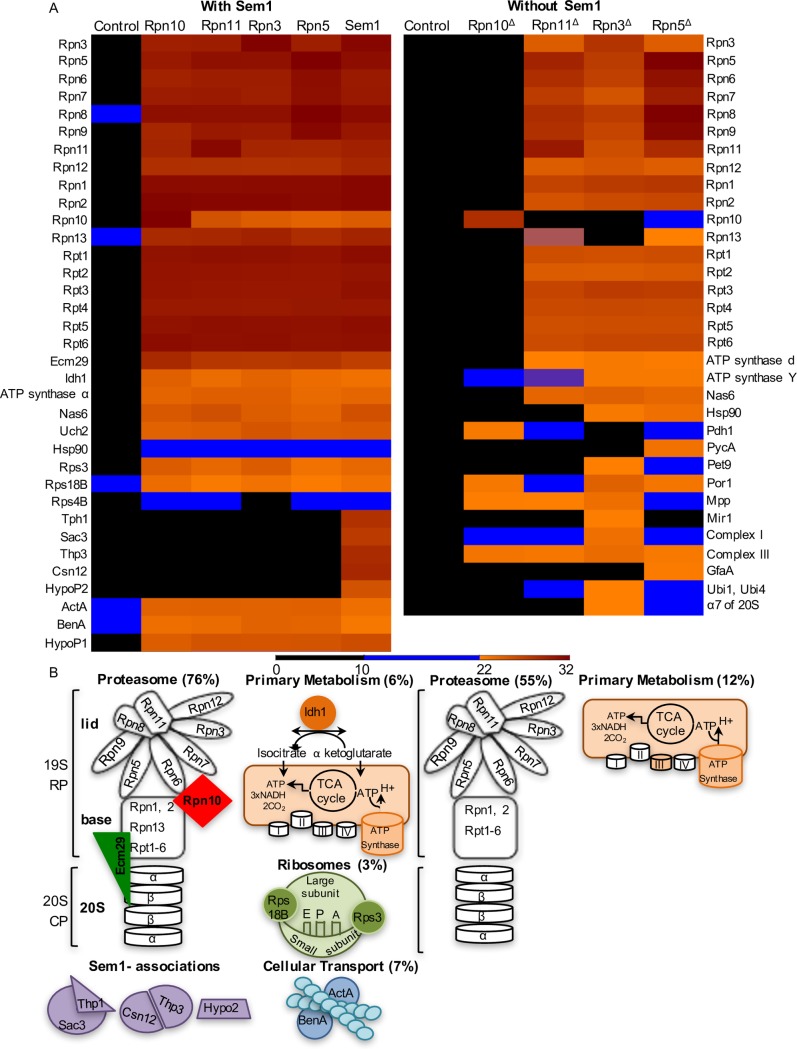
Proteins co-identified with Sem1 and 19S RP in the presence or absence of Sem1.(A) 34 proteins associated with 19S RP proteins fused to GFP in strains carrying Sem1. Proteins were identified in three biological replicates plotted as heat map representing LFQ intensities. HypoP1 and HypoP2 are conserved hypothetical proteins, with orthologs only among Aspergillus-related species. HypoP1 (AN2234) has no known conserved domain, whereas HypoP2 (AN4931) contains an Acyl-coenzyme A synthetase/AMP-(fatty) acid ligase domain (accession number COGO365). Lower panel: schematic representation of 30 proteins plotted in a heat map. Nas6, Hsp90, Uch24 and HypoP1 are not represented. (B) 33 proteins associated with 19S RP strains lacking sem1 (marked withΔ) identified in two biological replicates plotted as heat map representing LFQ intensities. Lower panel: representation of 20 proteins identified with all RP. 9 proteins are not represented including Nas6, Hsp90, Mpp and 6 mitochondria related proteins. Proteins identified with only one tagged RP protein and/or with MSMS counts ≥5 were not represented (total 4). Heat maps representing MS/MS counts were plotted in S5 Fig. Overexpressing GFP strain served as control. In the area of the heat map were LFQ intensities and MS/MS counts are low, proteins were considered identified only when both criteria were fulfilled: LFQ>22, MS/MS counts >4. (see also S4 and S5 Figs and S1 and S2 Tables).